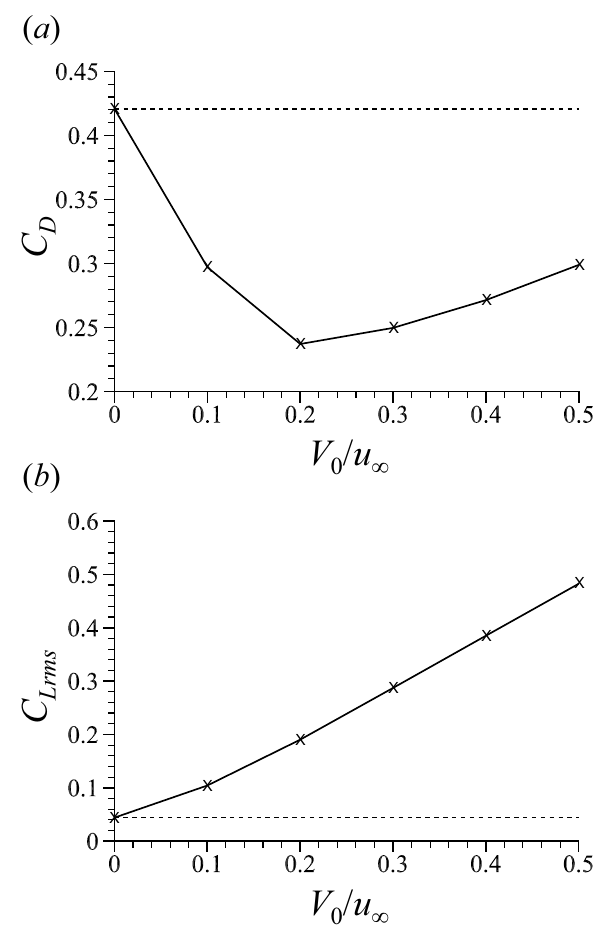
Figure 11. Variations of force coefficients according to the forcing amplitude V 0 / u ∞ with the fixed forcing frequency of f ∗ = 1.5: ( a ) mean drag coefficient ( C D ); ( b ) rms of lift coefficient fluctuations ( C Lrms ). Here, dashed line denotes values for the uncontrolled